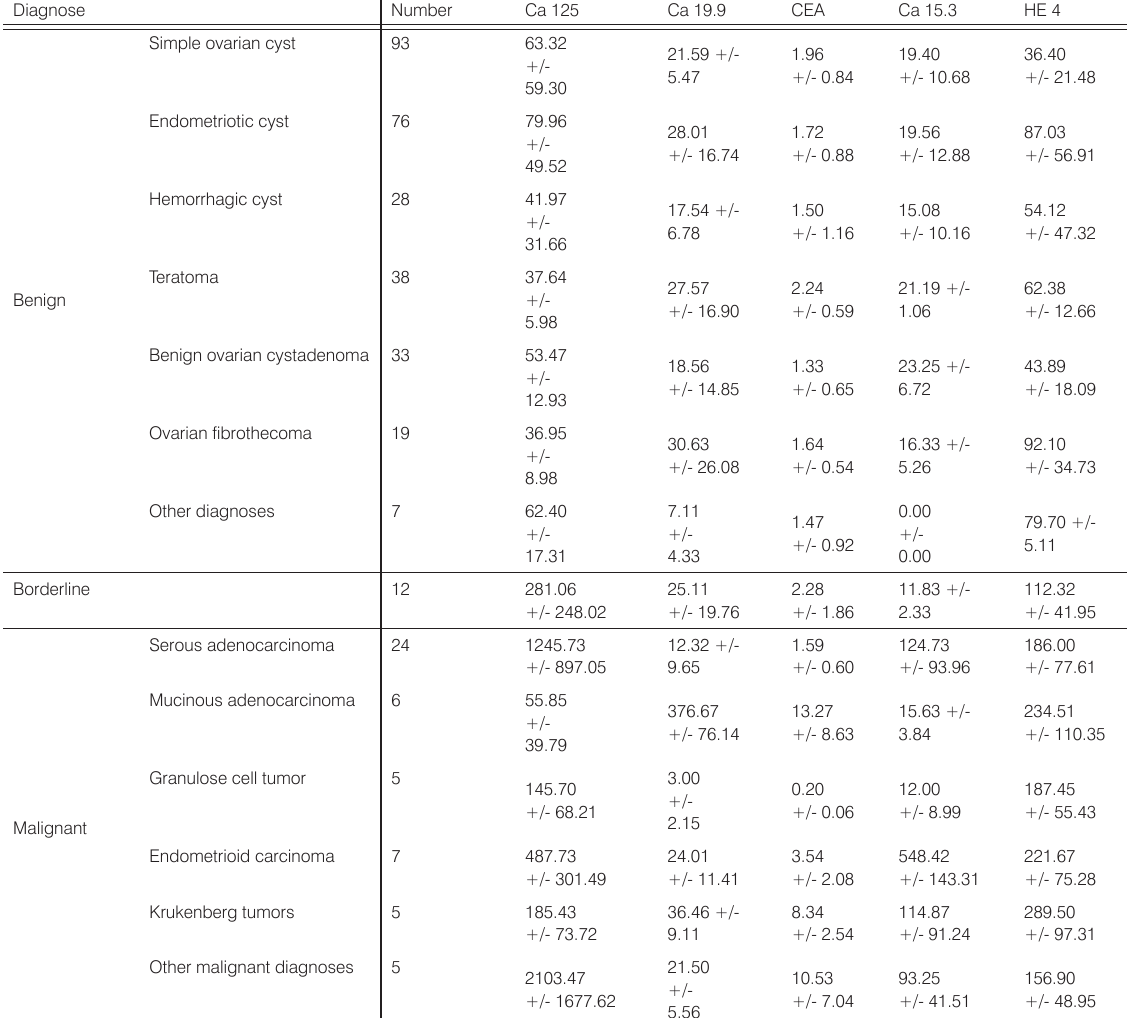
Table 1. Mean levels of serum tumor markers in different histopathological findings of adnexal masses Diagnose